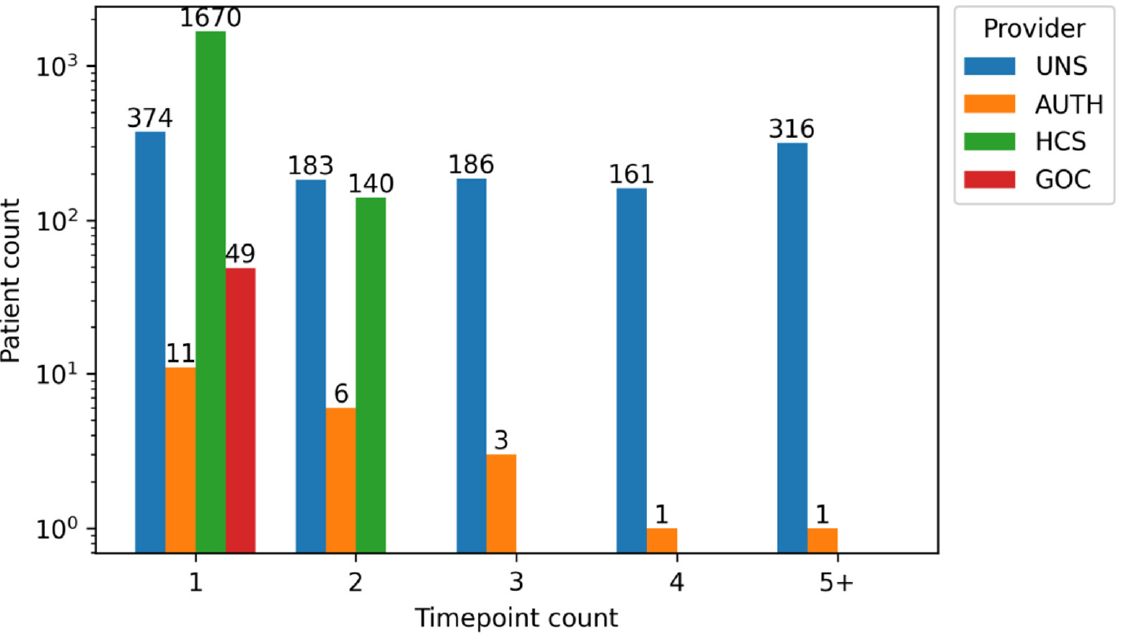
Figure 9. The number of patients with MG images in different numbers of TPs in the INCISIVE retrospective database.